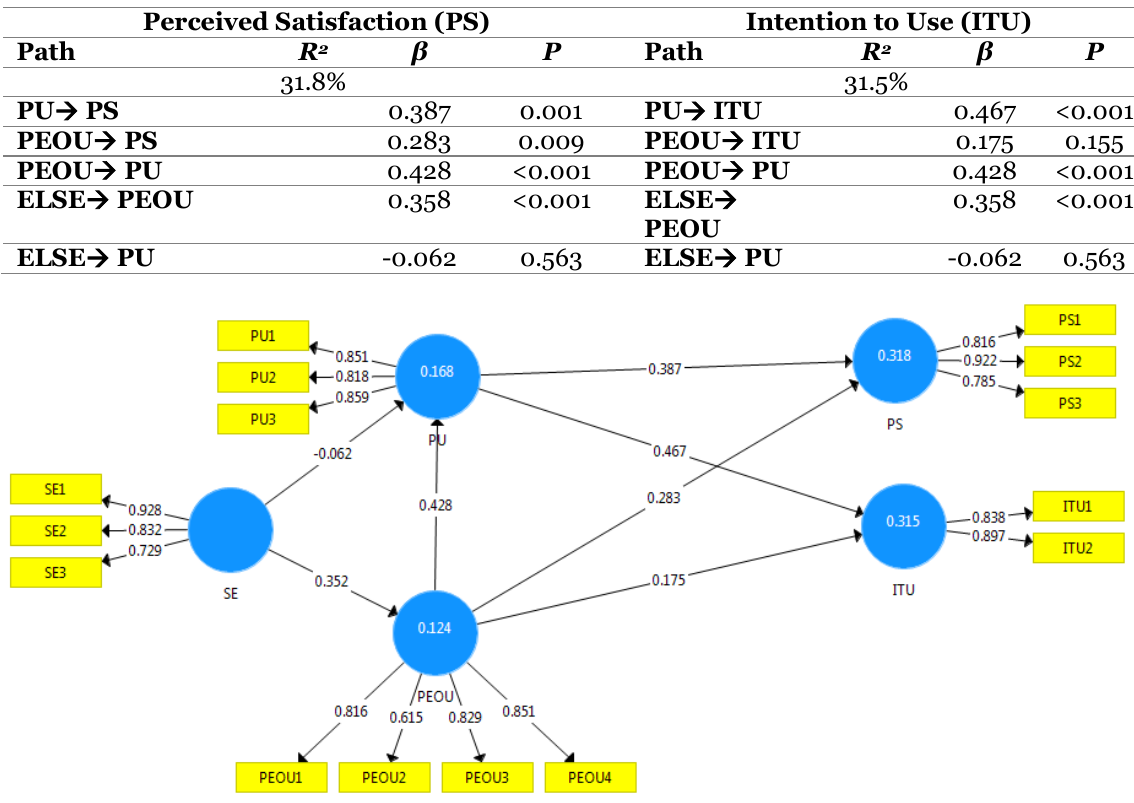
Figure 5. The findings of the original